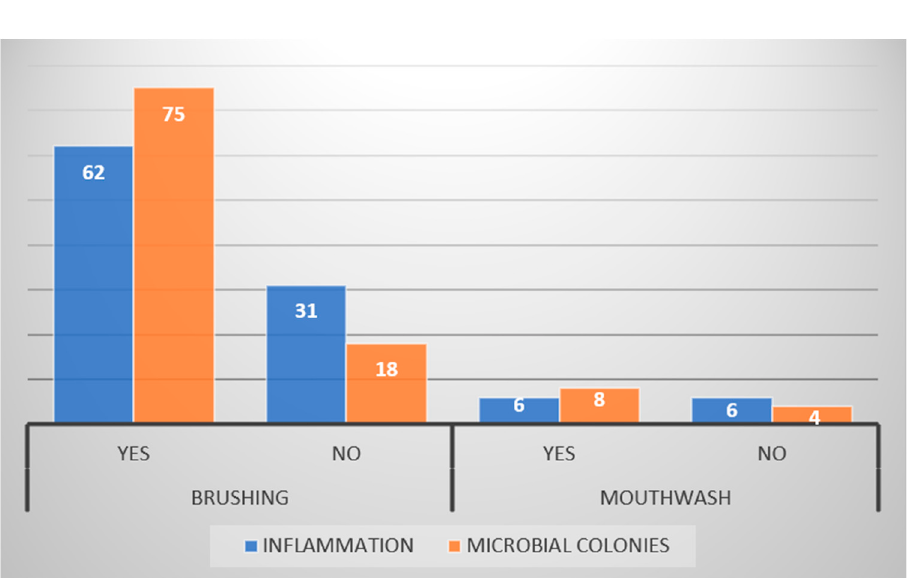
Figure 2 : Oral health maintenance habits’ effect on cytopathological findings (no relation was found among the demonstrated variables). p > 0.05.